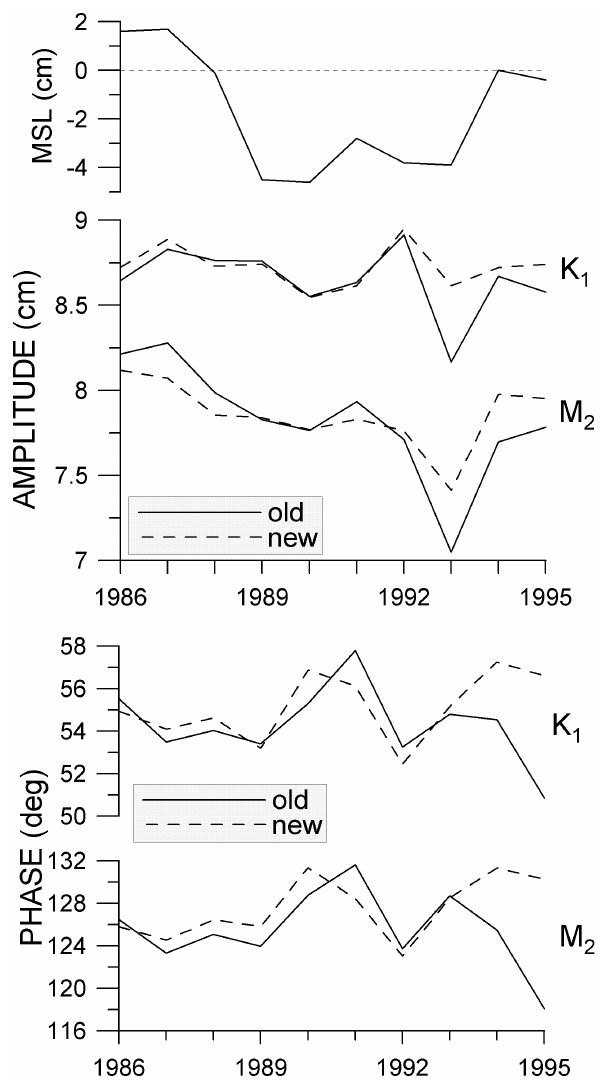
Fig. 4. Mean sea level (MSL) and amplitudes and phases of major M 2 and K 1 tides between 1986 and 1995, computed on the data obtained by the VAX (old) and the AutoCAD (new)